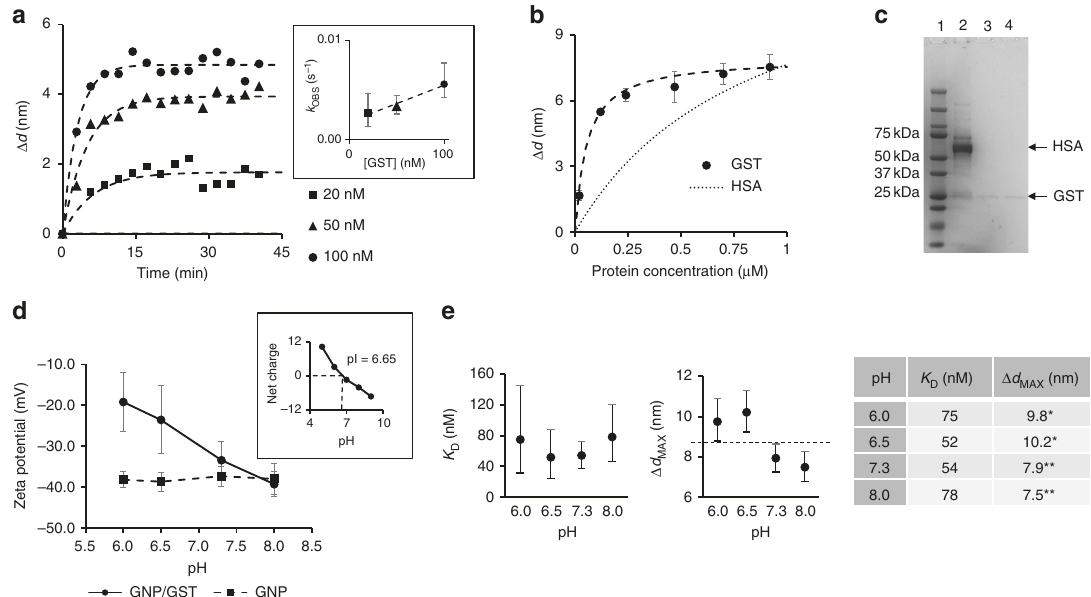
Fig. 1 Binding of GST to GNPs. a GST binding measured using time-resolved DLS and fi tted to a pseudo- fi rst order association kinetic model (dashed lines) was used to determine the observed association rate k OBS at the GST concentrations indicated. The inset shows the values of k OBS and their 95% con fi dence interval (vertical bars) determined from each binding curve as described in Methods section. The dashed line in the inset represents the fi t to the equation k OBS = k ON [GST] + k OFF , from which the on- and off-rates of GST/GNPs binding were determined. b Equilibrium binding data showing that GST has higher af fi nity to GNPs than HSA. Δ d values for GST were averaged over three measurements and the error bars represent standard deviations. The dashed line is the best fi t of GST data to the binding model used, whereas the dotted line is a representation of an ideal binding curve of HSA binding to GNPs, based on a previously reported K D and a Δ d MAX of 14 nm. The latter was used assuming a complete corona with a thickness that equals the hydrodynamic diameter of serum albumin (~7 nm). c SDS-PAGE of GNPs incubated in human serum (HS). Lane 1: protein marker (relevant molecular weights are shown on the left); lane 2: unprotected GNPs incubated in HS showing prominent binding of HSA; lane 3: GST-protected GNPs incubated in HS showing no binding of HSA; lane 4: control GST-GNPs which were processed like lane 3 but not incubated in HS. d Zeta potential of GST-coated GNPs (solid line) measured at different pH, showing a marked increase at pH lower than pI. Naked GNPs (dashed line) are highly negative at all pH. The data are averages of three measurements and the error bars represent standard deviations. The inset shows the predicted net charge and pI of GST calculated using APBS algorithm at pH 5 – 9. e 95% con fi dence intervals of GST/GNPs K D (left), Δ d MAX (center) and tabled data (right) at different pH. The Δ d MAX estimates (also listed in the table inset) are signi fi cantly different, as indicated by the dashed horizontal